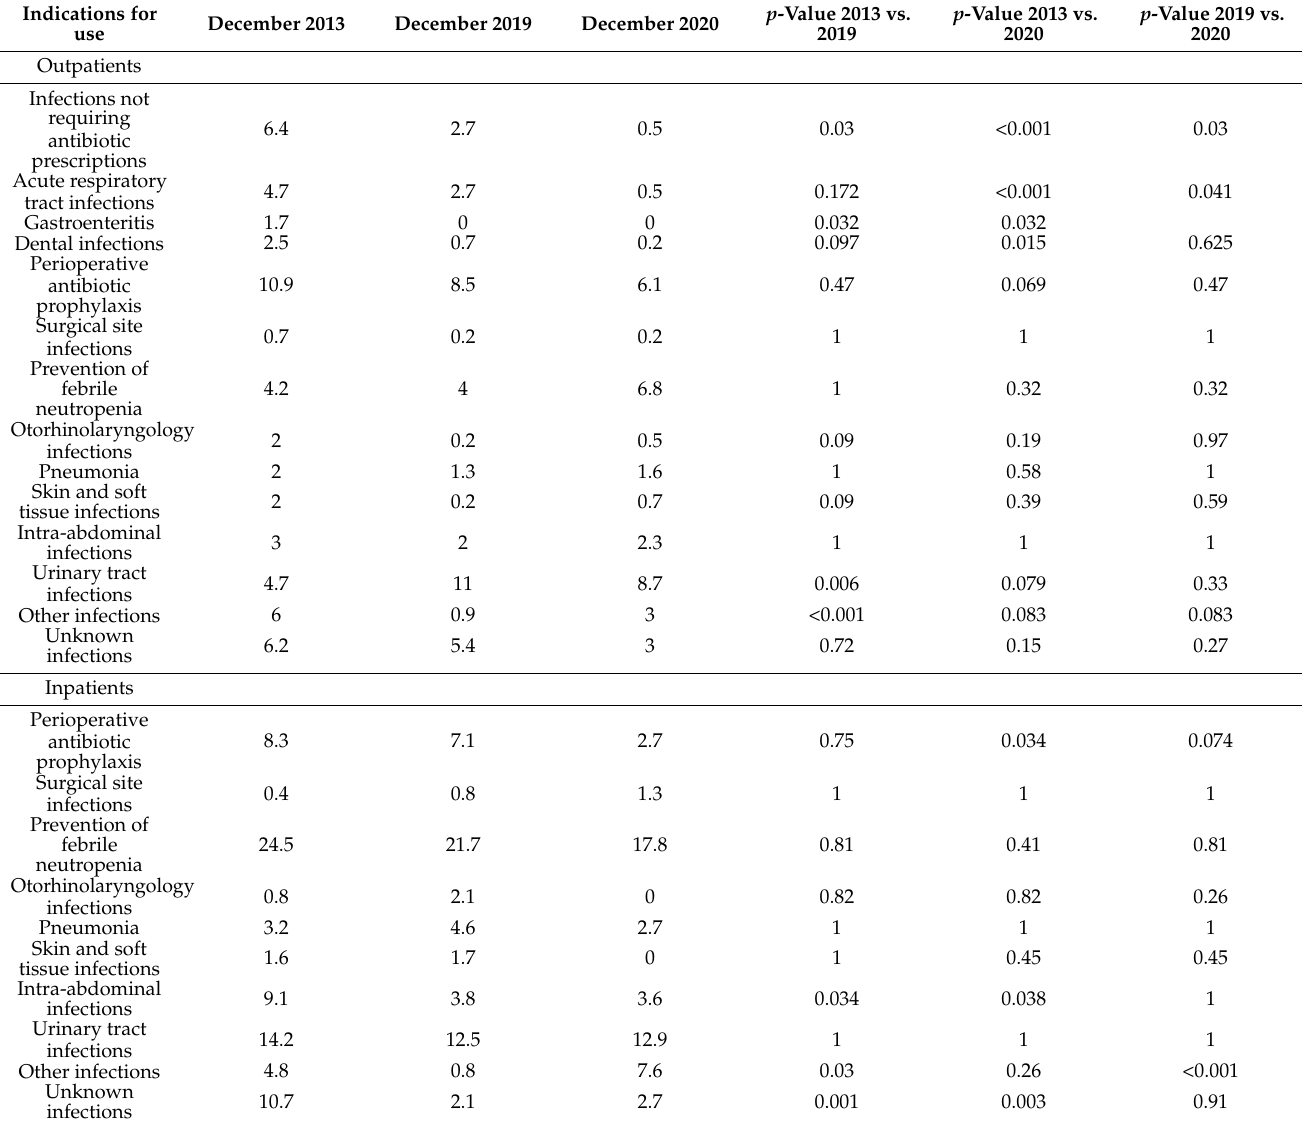
Table 2. Frequency of oral quinolone prescriptions in each indication (prescriptions/10,000 patient-days). Indications for